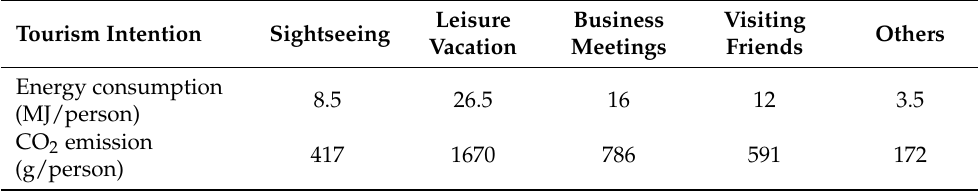
Table 2. Energy consumption and carbon emissions of tourism